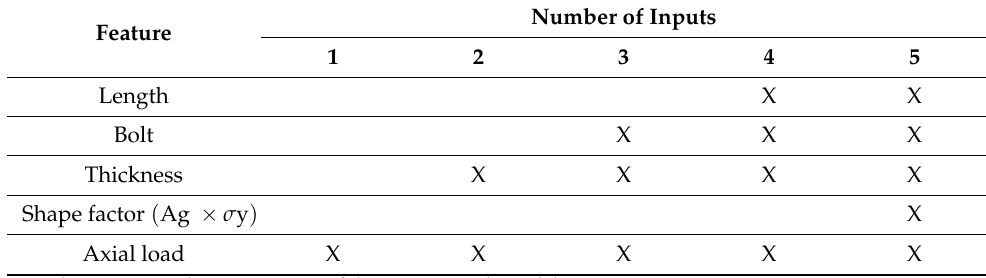
Table 9. Selected input composition for displacement prediction based on feature-selection method